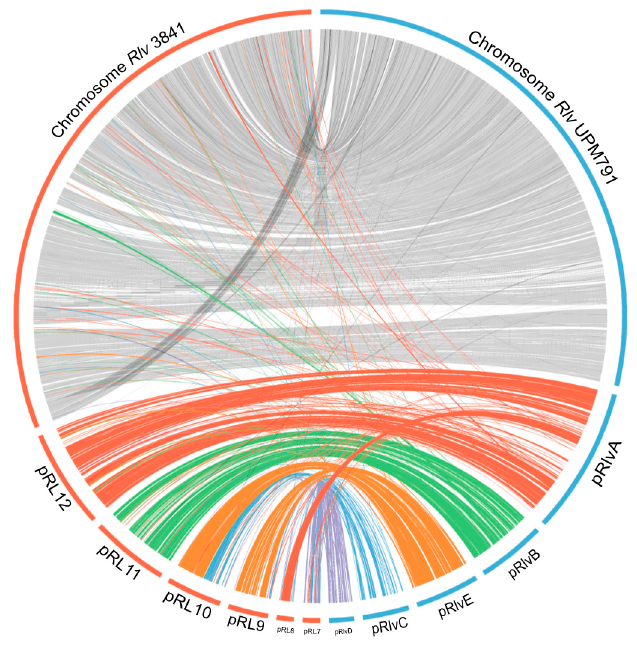
Figure 4. Circos representation of synteny between Rlv UPM791 and Rlv 3841 replicons.